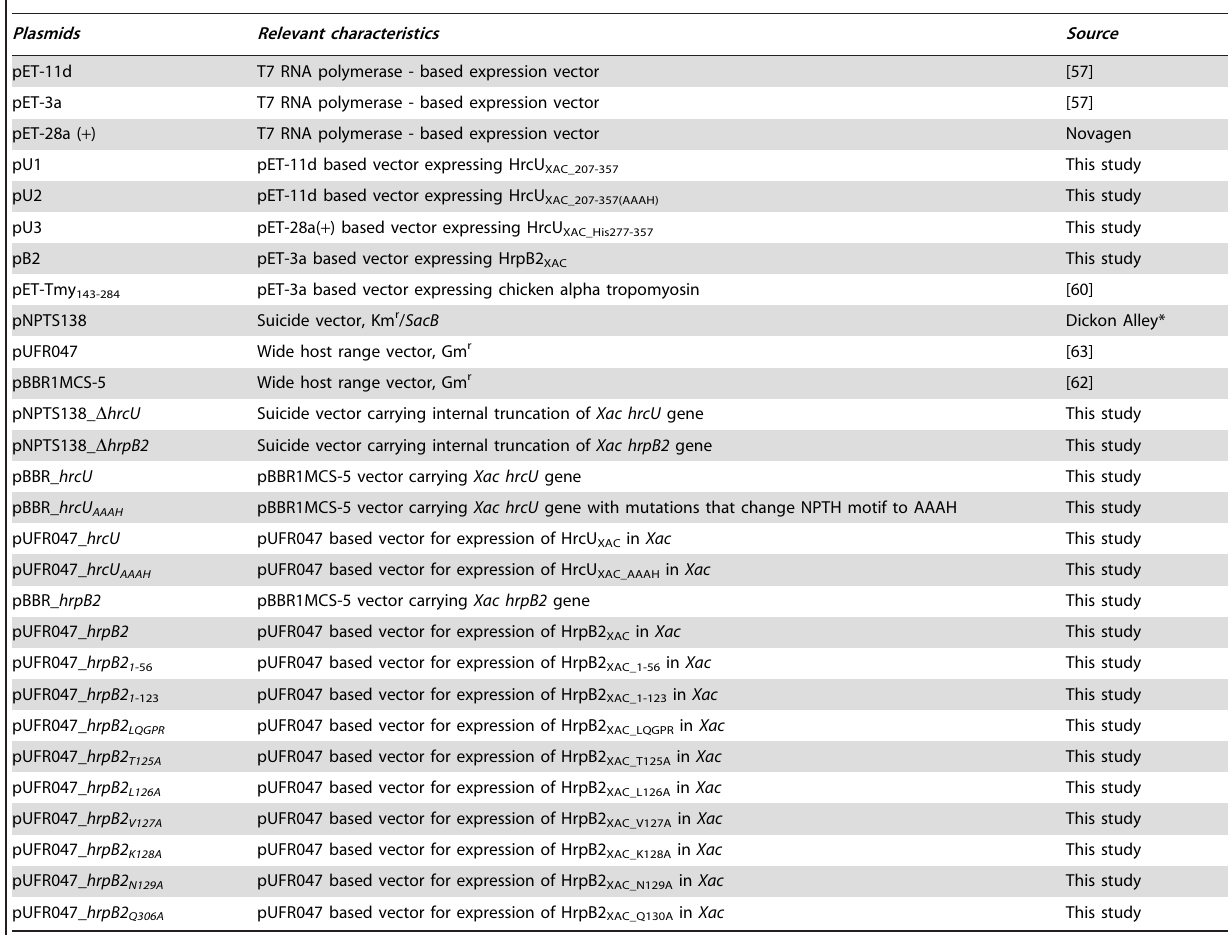
Table 2. Plasmids used in this